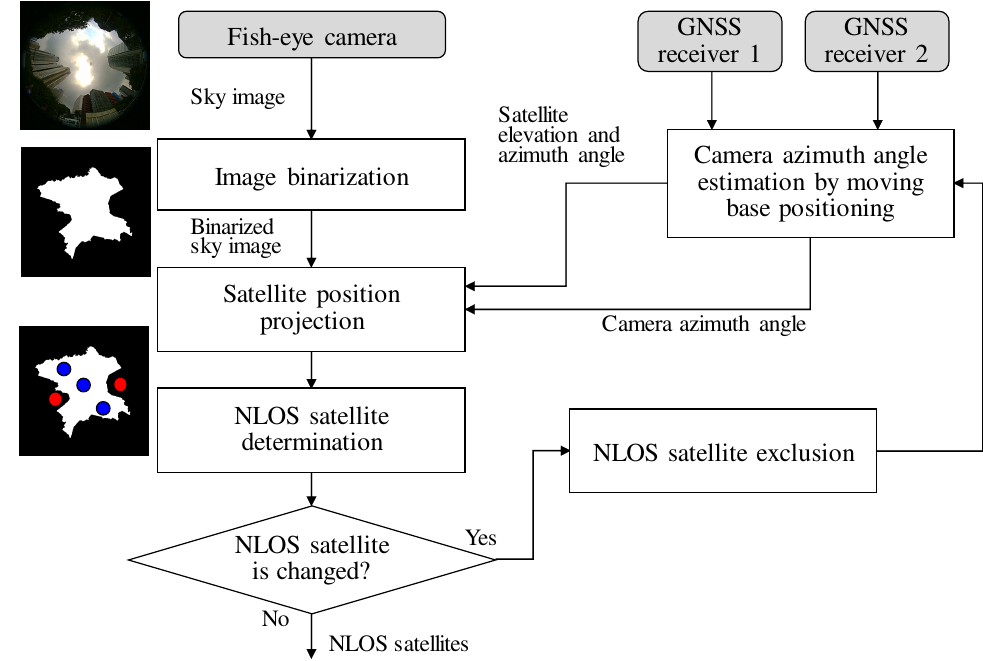
Figure 8. Flow of NLOS satellite determination using a fish-eye image. We iteratively calculate the azimuth angle of the camera and determine the NLOS satellite from the fish-eye